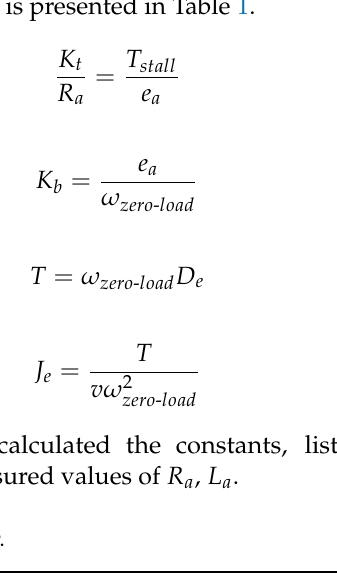
be presented by using v = r ω L . The ω L is the load shaft angular velocity (as shown in Figure 3) with its gear ratio, and the angular velocity of the motor is ω m . The gear-motor is possessed by TPR, so we are using gear ratio with the help of Equations (9)–(12). The